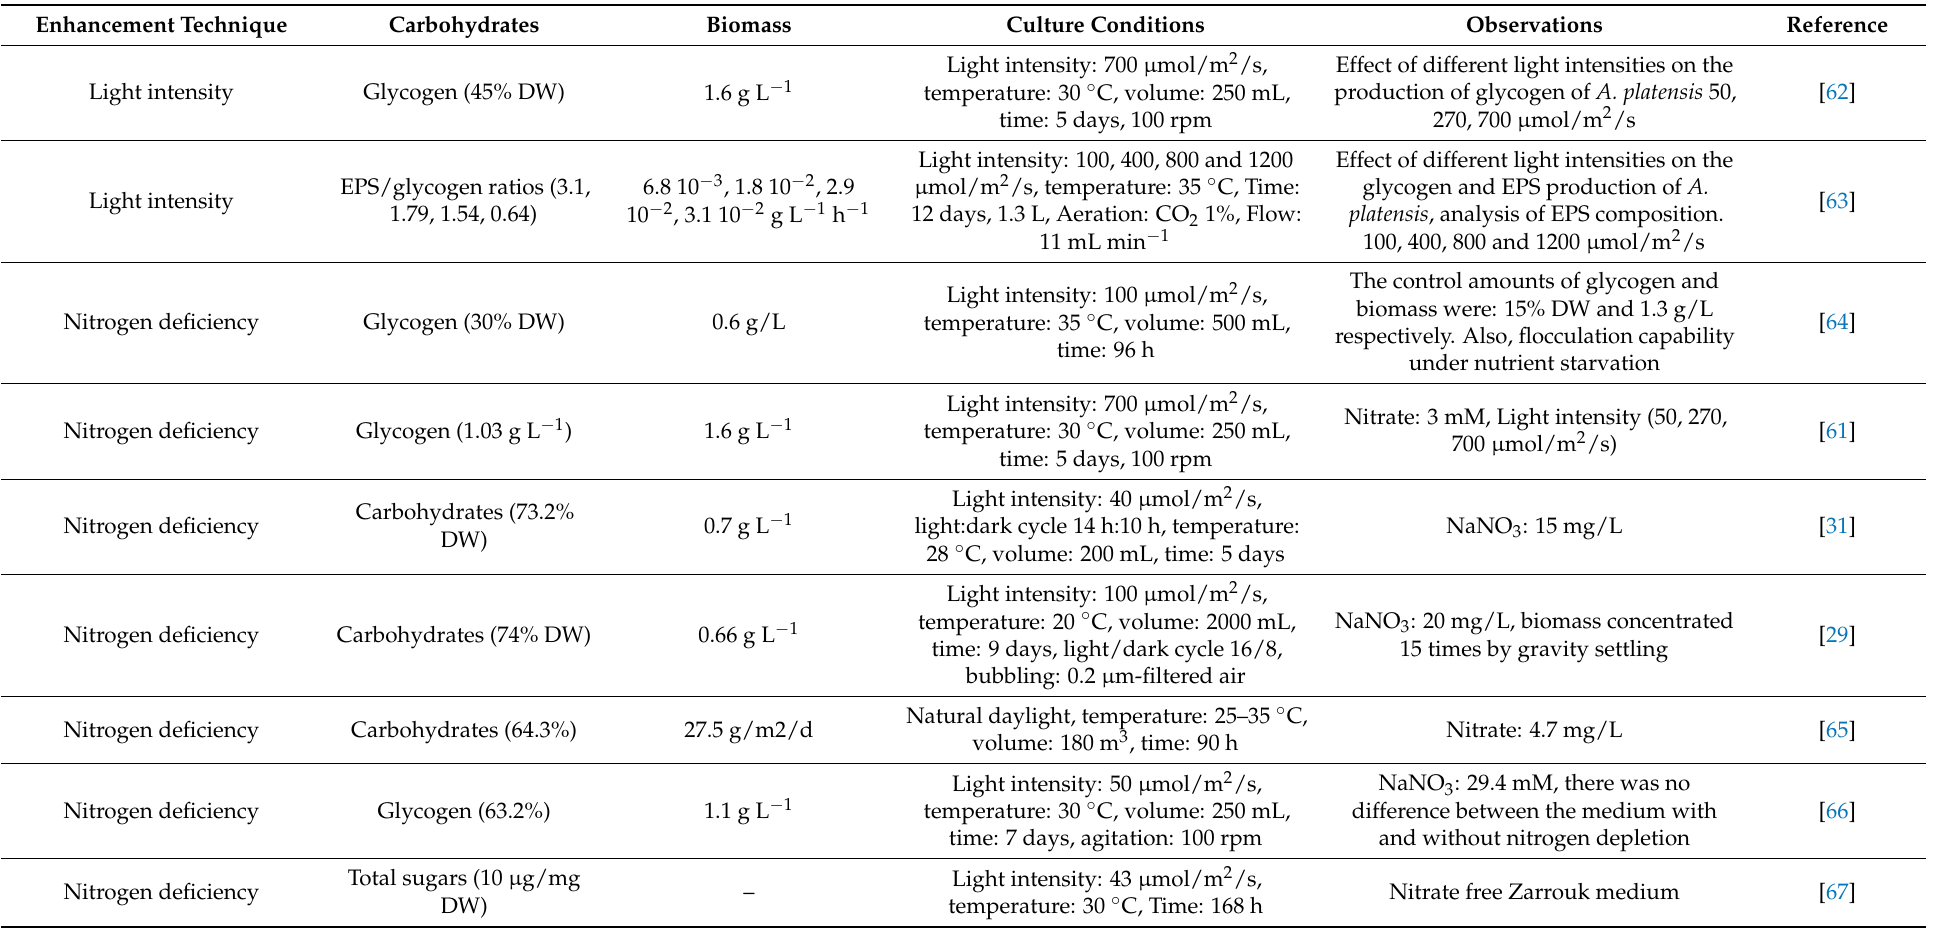
Table 1. Glycogen accumulation strategies for Arthrospira platensis